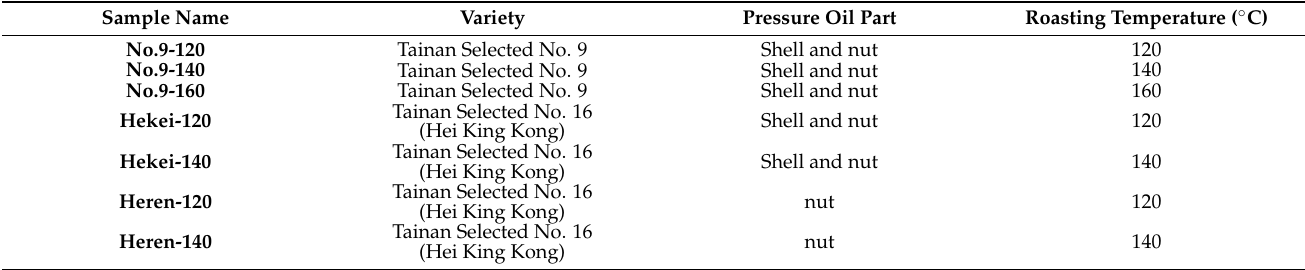
Table 2. The study of collections of taxa currently assigned to peanut oil.